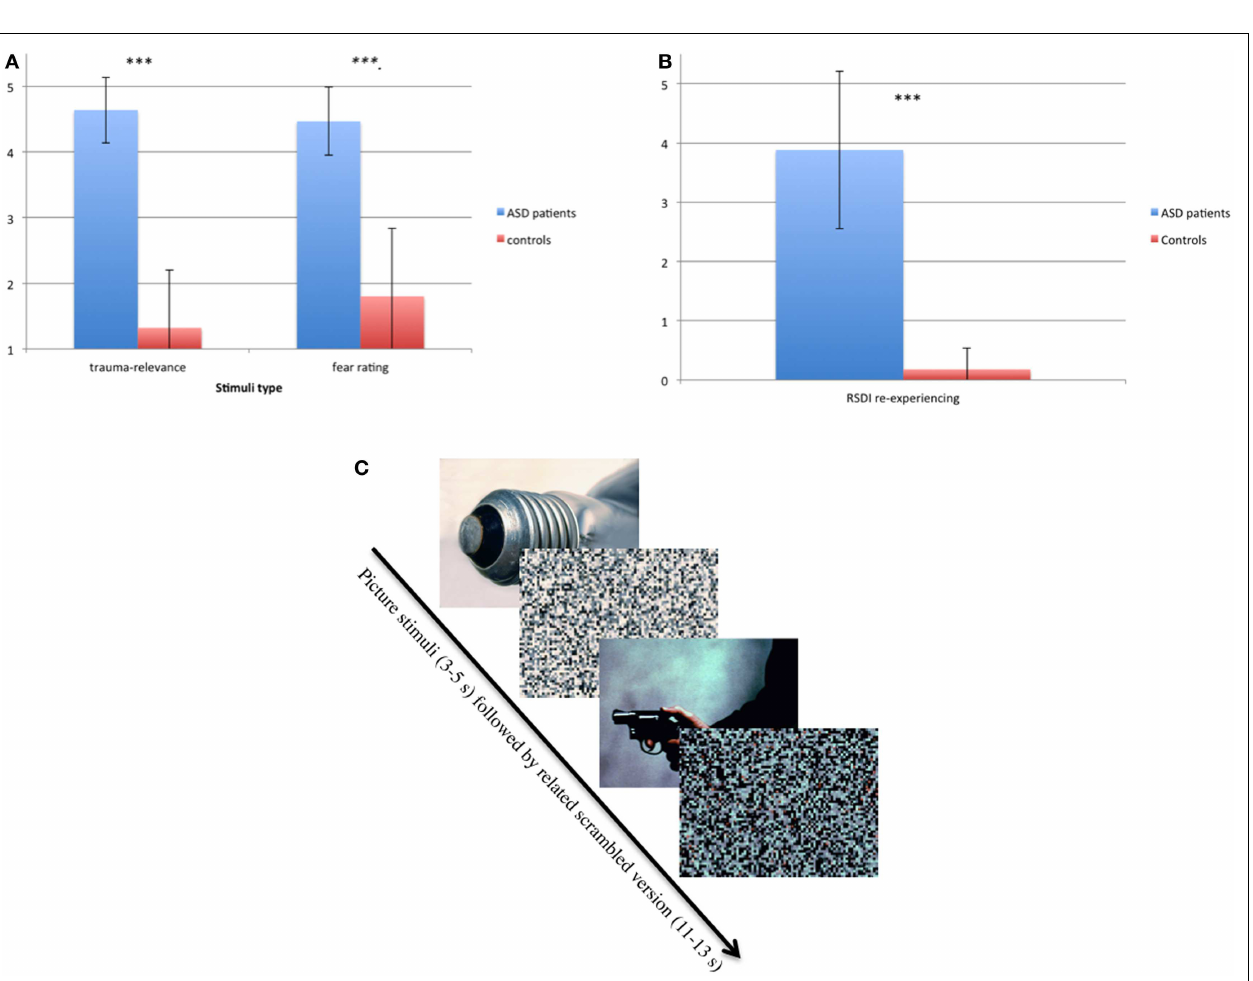
FIGURE 1 | (A) Ratings of trauma relevance (1–5) and fear-inducing ratings (1–5) of trauma-relevant pictures in ASD and control participants. *** p < 0.001. (B) Ratings of re-experiencing measured with RSDI (0–6) in ASD and control